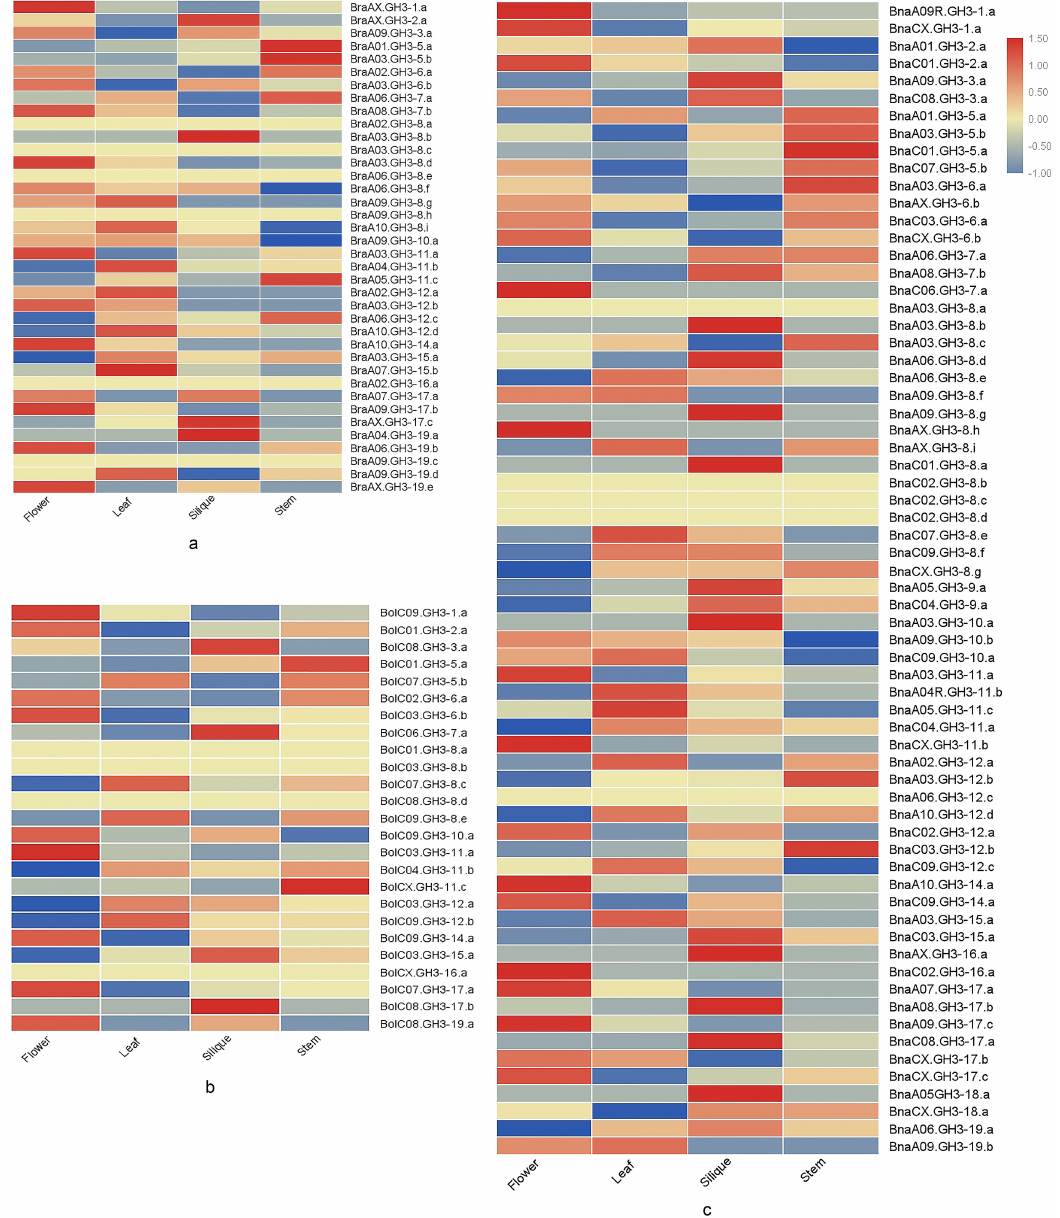
Figure 7. The expression profiles of GH3 genes in different tissues for the three species of Brassica . ( a ) B. rapa ; ( b ) B. oleracea ; ( c ) B. napus